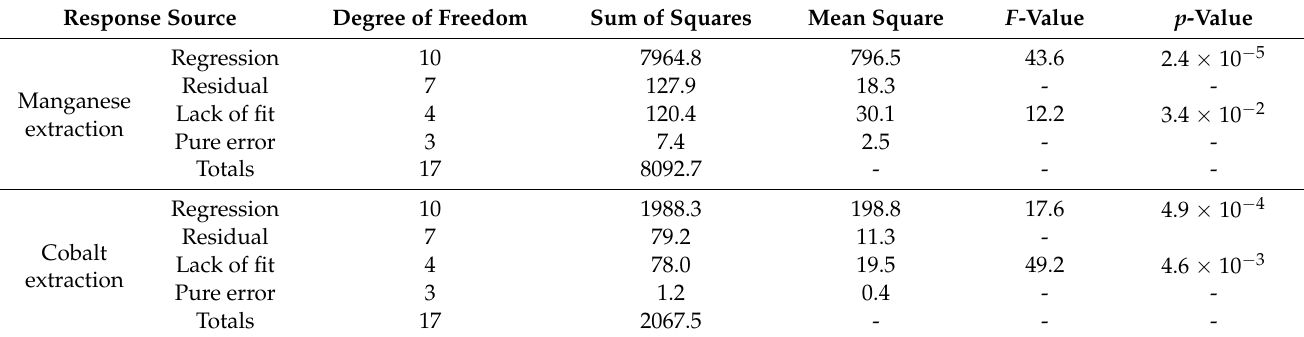
Table 4. Results of the analysis of variance of the fitted models for the extraction of manganese and cobalt.